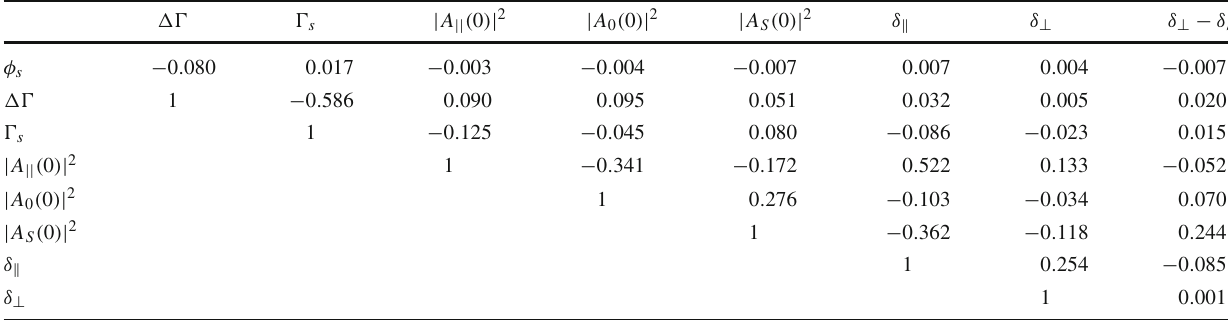
Table 7 Fit correlations between the physical parameters of interest, obtained from the fit for solution (a)